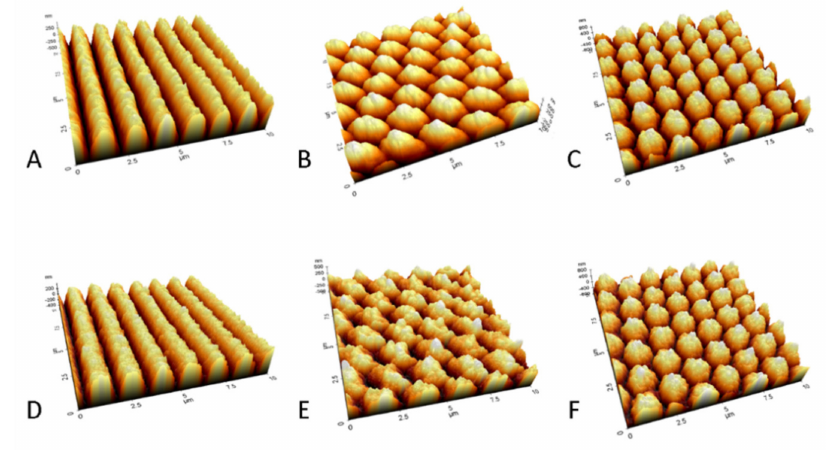
Figure 6. Surface topology analyzed by atomic force microscopy (AFM): ( A – C ): structures on stainless steel; ( D – E ): structures on titanium; A&D: structure 1-5; B&E: structure 2-5; C&F: structure 5-5. Stainless steel showed at least 100 nm deeper structures then titanium for these structure